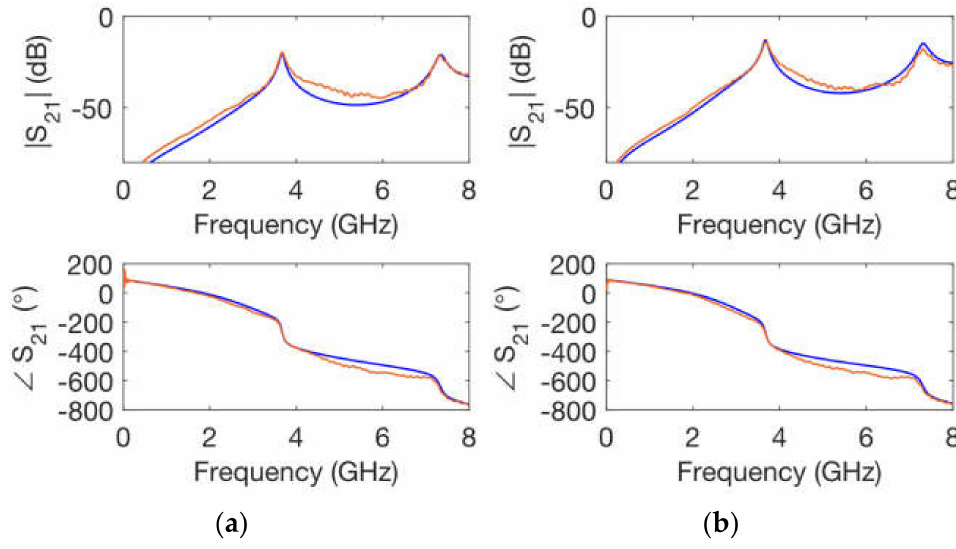
Figure 11. Simulated ( blue ) and measured ( orange ) ring resonator network magnitude and phase of the transmission coefficient: ( a ) h = 1.0 mm substrate height; ( b ) h = 1.6 mm substrate